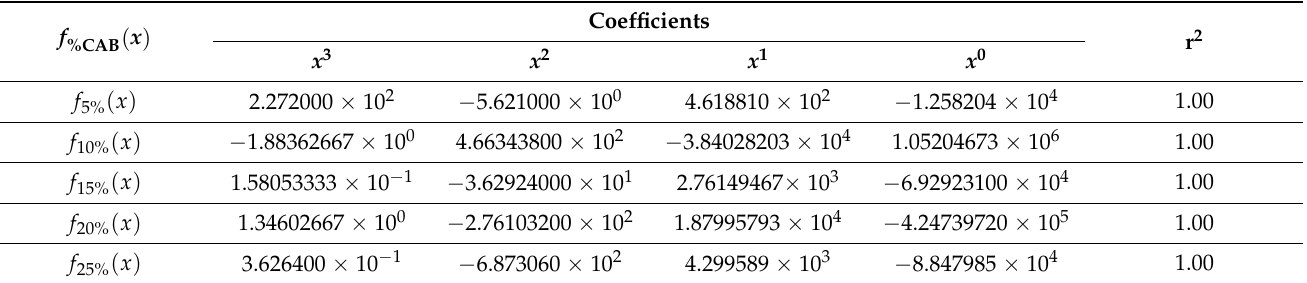
Table 2. The local models of each %CAB.